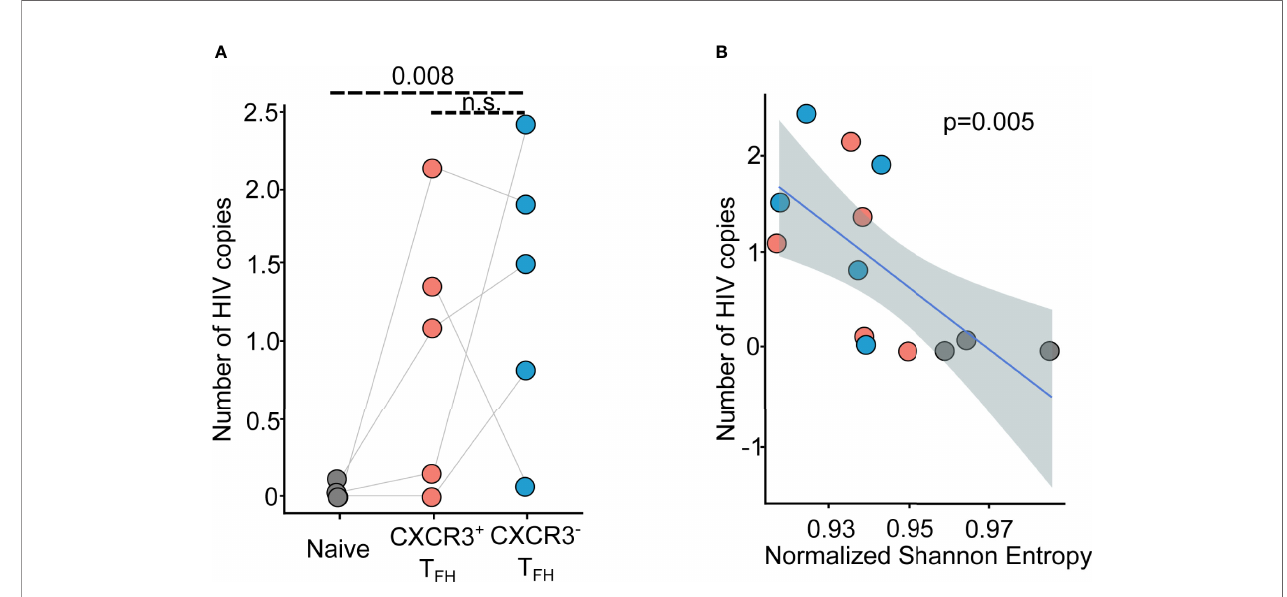
FIGURE 5 | HIV transcript mapping shows CXCR3 + T FH is one major reservoir of HIV viruses. (A) Dot plot shows the distribution of normalized HIV copy number across donors and T cell populations (n = 5); n.s.: not signi fi cant; (B) Scatter plot shows the correlation between normalized HIV copy number versus Normalized Shannon Entropy (NSE). Blue line represents the regression line, while the dashed area shows the 95% con fi dent